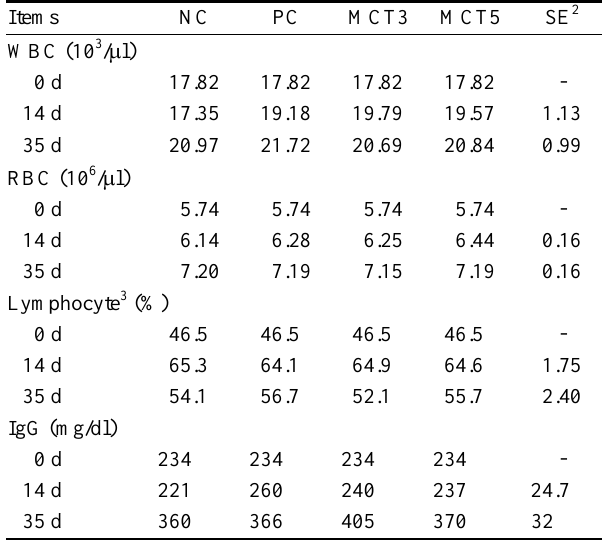
Table 6. Effect of medium-chain-triglyceride on apparent total tract nutrient digestibility (ATTD) of weanling pigs (Exp. 2) 1 Items